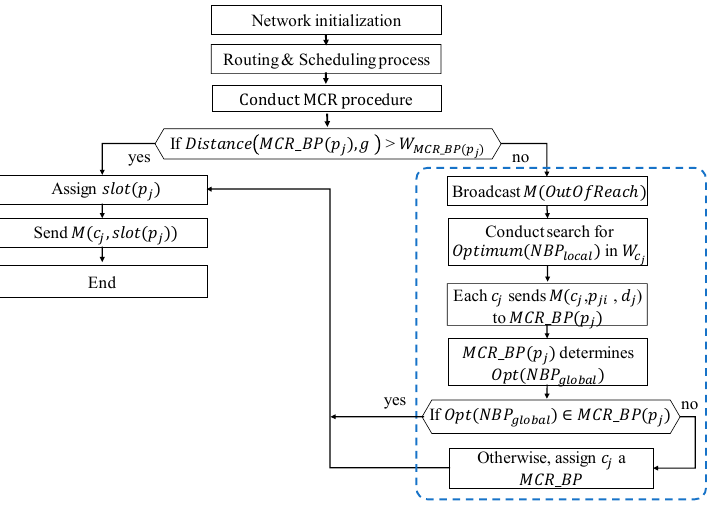
Figure 6. A flow diagram of proposed NE-MCR algorithm.